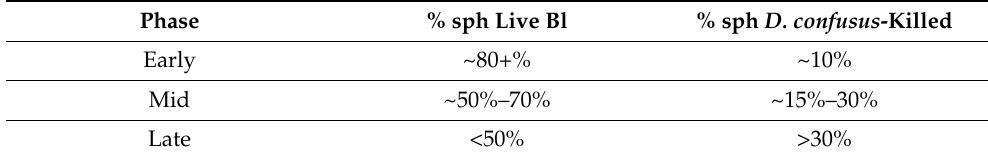
Figure 8. Blue box plots show diameter at breast height (dbh) of subalpine fir dead from other causes (standing and down), killed by D. confusus (standing and down), and standing live trees showing mean (X), median (line), and range. Table 5. The estimated percentage of live subalpine fir and stems per hectare (sph) of D. confusus -killed subalpine are listed for the three outbreak